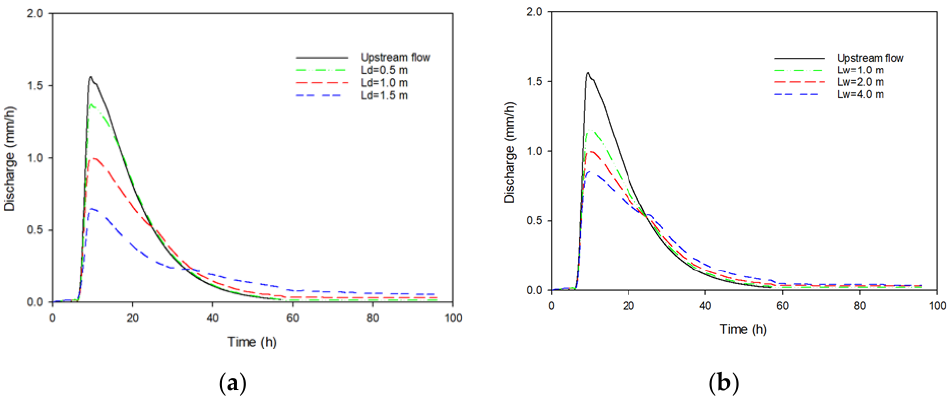
Figure 6. Hydrographs of off-line ditch-pond system with different weir specifications. ( a ) 𝐾 𝑠𝑝 = 0.05, 𝐿 𝑤 = 2.0 m; ( b ) 𝐾 𝑠𝑝 = 0.05, 𝐿 𝑑 = 1.0 m.